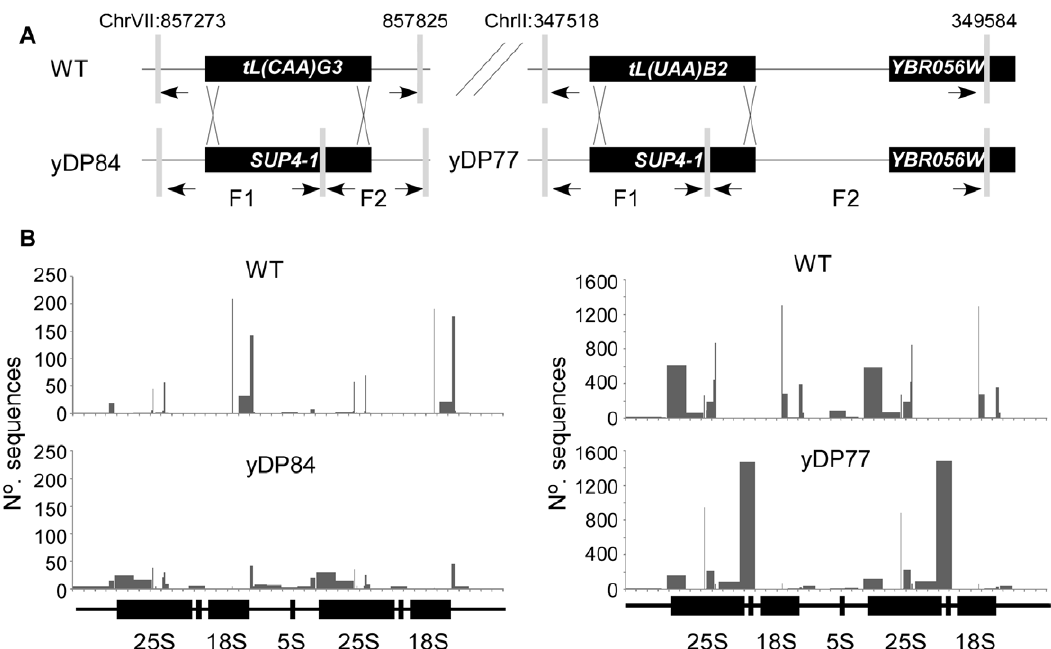
Figure 2. tRNA identity dictates interaction patterns with the ribosomal DNA locus. A) Two leucine tRNA genes (tL(CCA)G3 and tL(UAA)B2), which are located on separate chromosomes, were replaced with the tyrosine tRNA SUP4 -1 suppressor gene to generate strains yDP84 and yDP77. Grey bars denote Msp I restriction sites, arrows denote 4C primer positions. B) Interactions with the rDNA locus were identified by 4C coupled to high through-put sequencing (Methods S1). Raw interaction frequencies have been plotted across a tandem rDNA repeat for clarity. Note, only patterns of interaction along the rDNA locus should be compared as inter-experiment variation has not been corrected for.